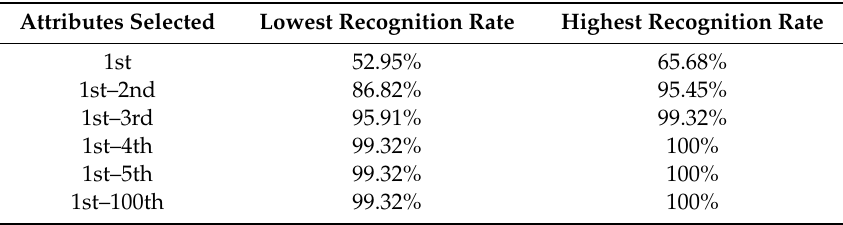
Table 1. Search process of the optimum subset.